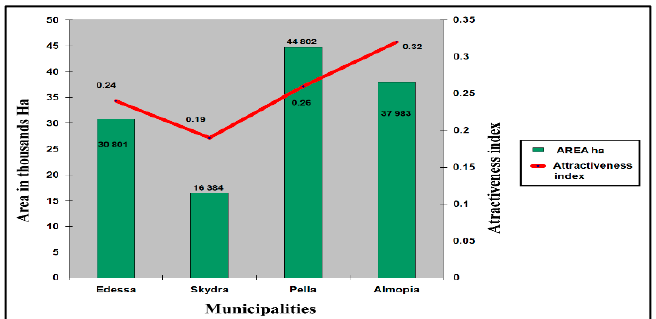
Figure 6. Covered areas and Total Attractiveness Index (RAI T ) values.